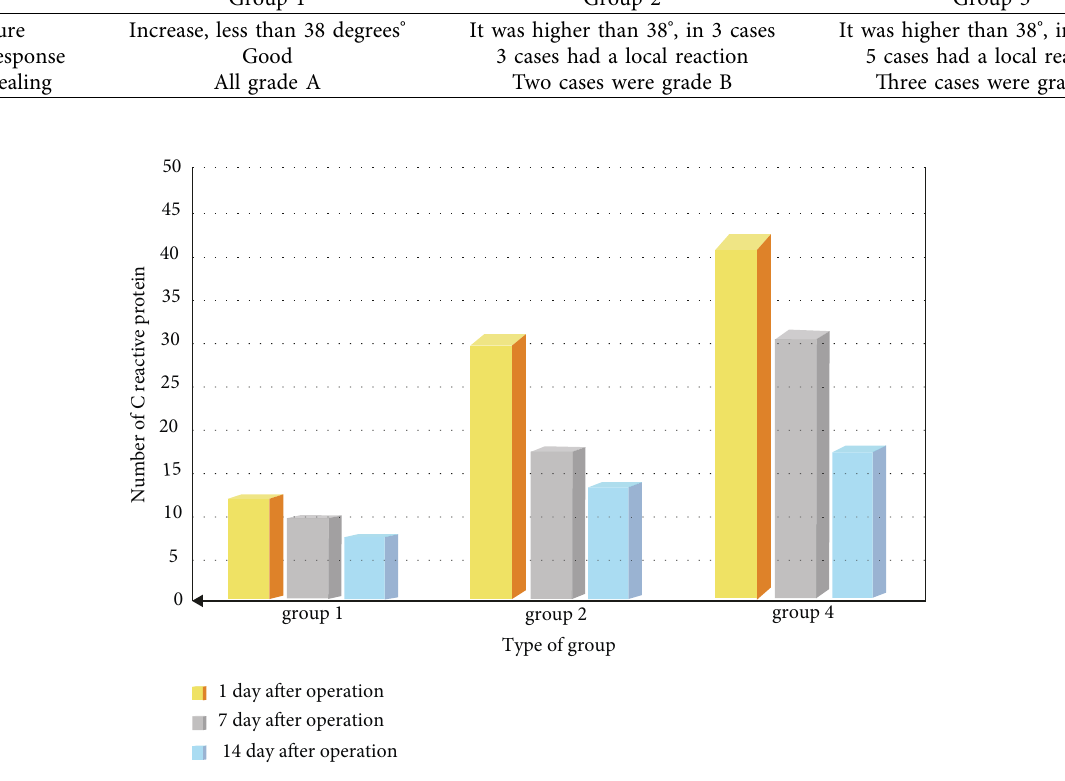
Figure 1: Changes in reactive protein after an